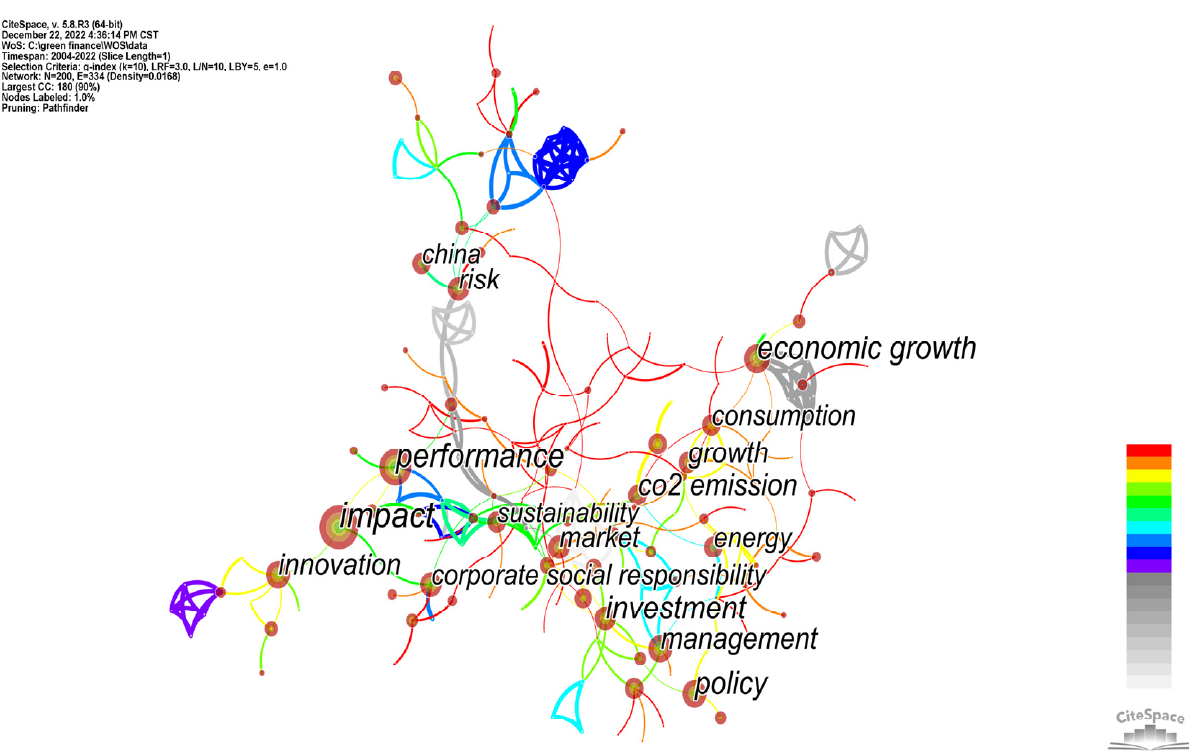
Figure 9. WOS keyword co-occurrence.